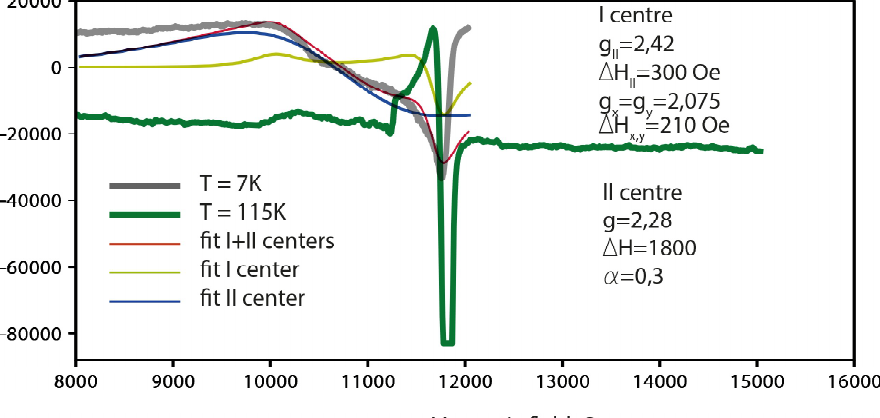
Fig. 3. Electron spin resonance (ESR) spectra of studied glass in the Q-band (at 34 GHz). Thick lines are the result of experimental measurements; thin lines are the fitting